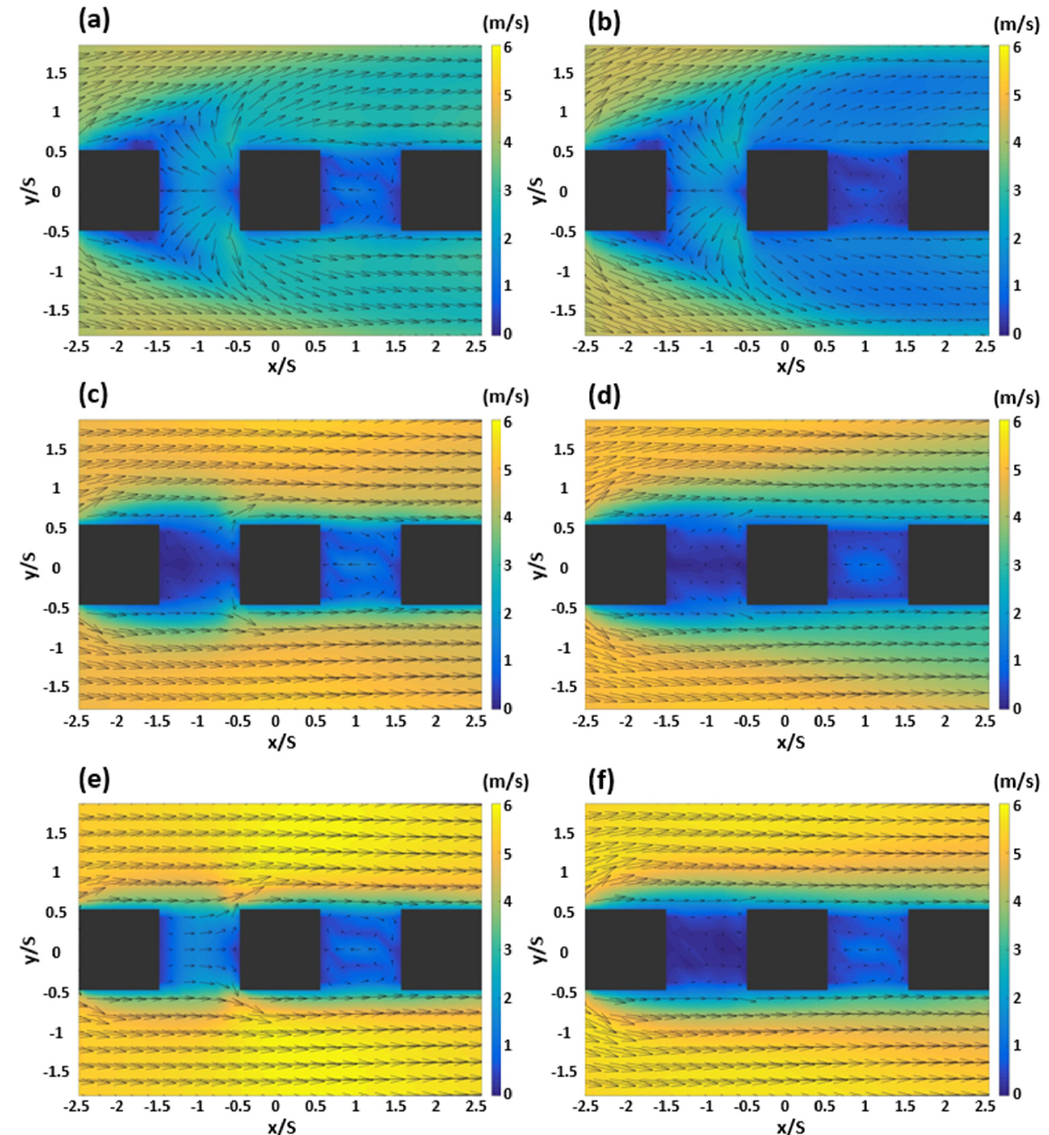
Figure 3. Wind field and wind speed of step-up to step-down (Case 1) in the shallow canyons (left panel) and deep canyons (right panel). ( a , b ) z/S = 0.2; ( c , d ) z/S = 0.6; ( e , f ) z/S = 1.0.